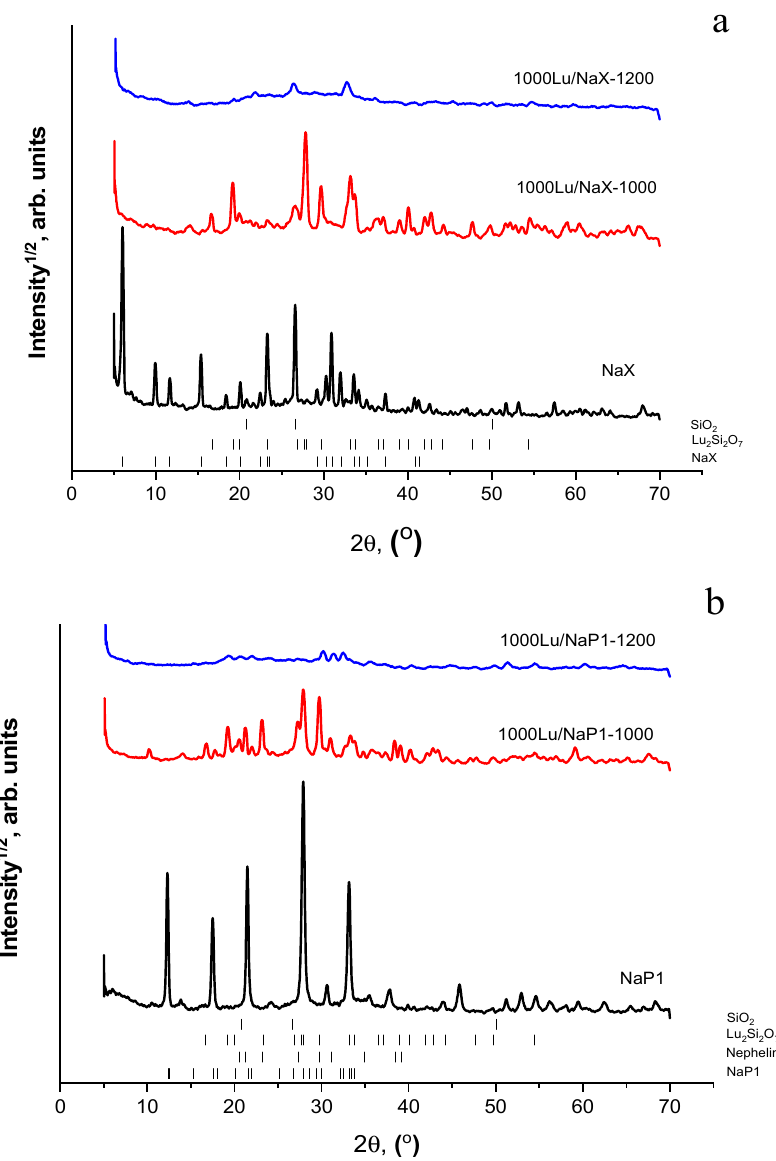
Figure 2. PXRD patterns of products resulted from hydrothermal processing of the NaOH-H 2 O-(SiO 2 -Al 2 O 3 ) glass system at ( a ) 353 K and ( b ) 393 K; products of solid-phase recrystallization of the Lu 3+ loaded NaX ( a ) and NaP1 ( b ) bearing microspheres at 1273 K (1000Lu/NaX-1000, 1000Lu/NaP1-1000) and 1473 K (1000Lu/NaX-1200, 1000Lu/NaP1-1200).